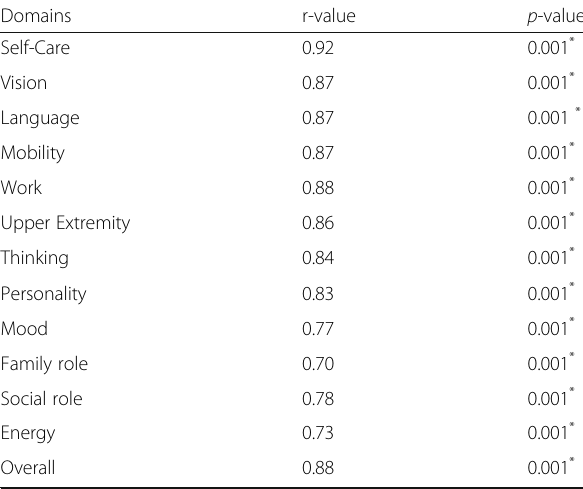
Table 4 Spearman ’ s Correlation of Participants ’ Scores on English and Hausa versions of SS-QoL 2.0 scale